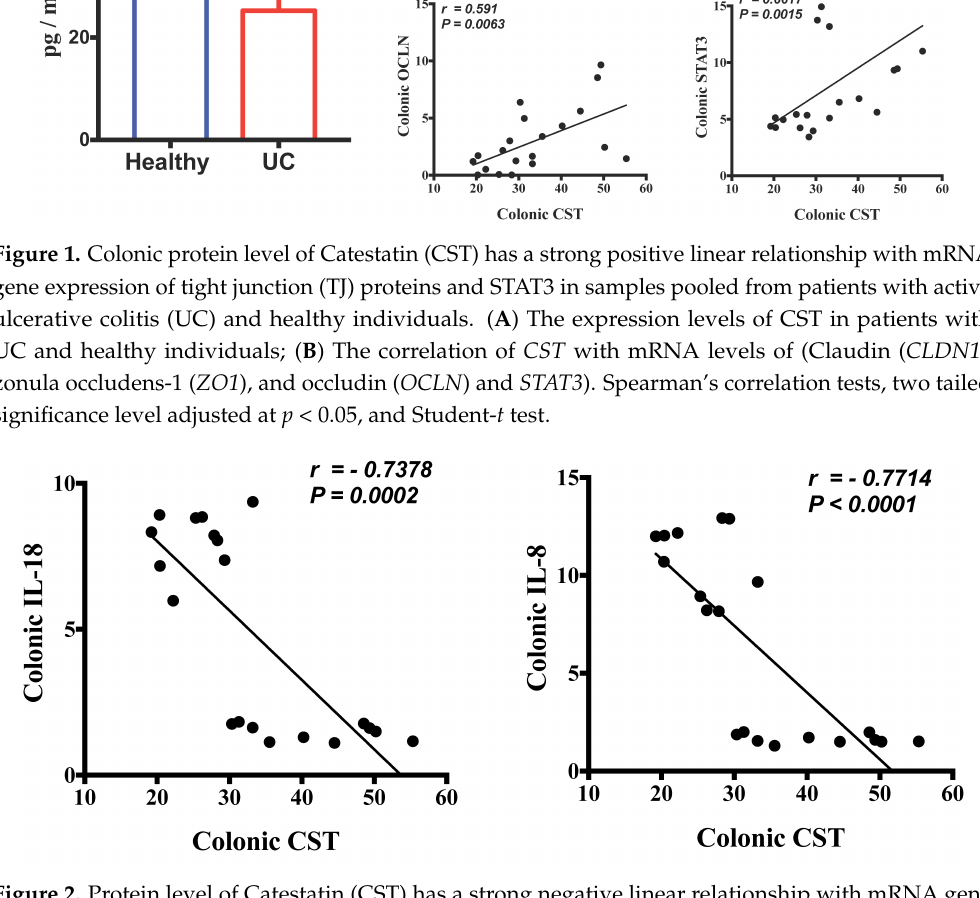
Figure 2. Protein level of Catestatin (CST) has a strong negative linear relationship with mRNA gene expression of epithelial associated cytokines in pooled samples from patients with active ulcerative colitis (UC) and healthy patients. The correlation of CST protein levels with mRNA levels of interleukin ( IL ) -8 and IL-18 . Spearman’s correlation, two tails significance level adjusted at